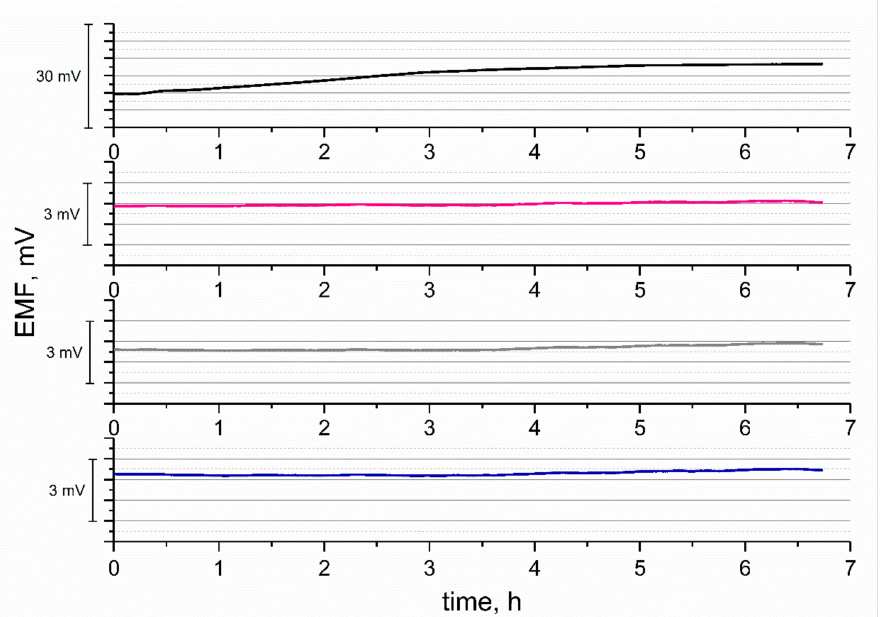
Figure 9. Stability test—potentiometric response of GC/CB+RuO 2 /K + -ISM (pink line), GC/NT+RuO 2 /K + -ISM (grey line), GC/GR+RuO 2 /K + -ISM (blue line), and GC/K + -ISM (black line) electrodes, over 6 h, conducted in 10 − 2 M K +